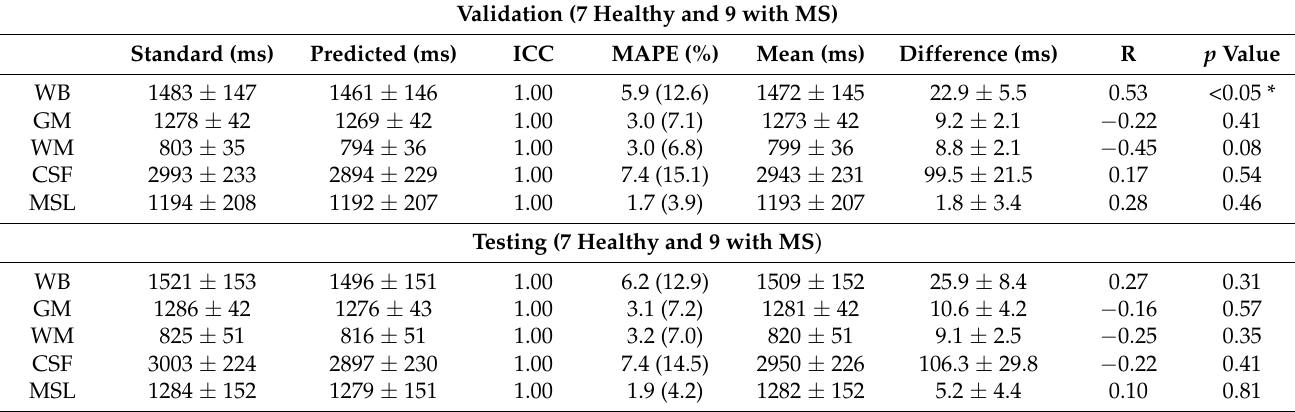
Table 2. Statistical analysis of T1 relaxation times between dictionary matching and the proposed two-stage model for each tissue of scanned data.